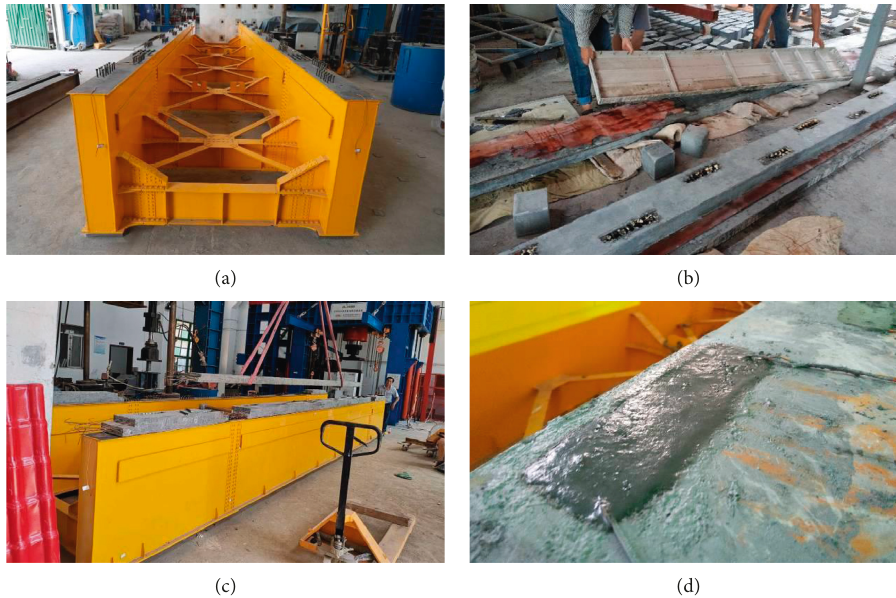
Figure 6: Prefabrication and assembly of the test beam in the laboratory. (a) Prefabricated steel beam. (b) Prefabricated concrete slab. (c) Hoisting of prefabricated concrete slab. (d) Pouring of reserved notches.